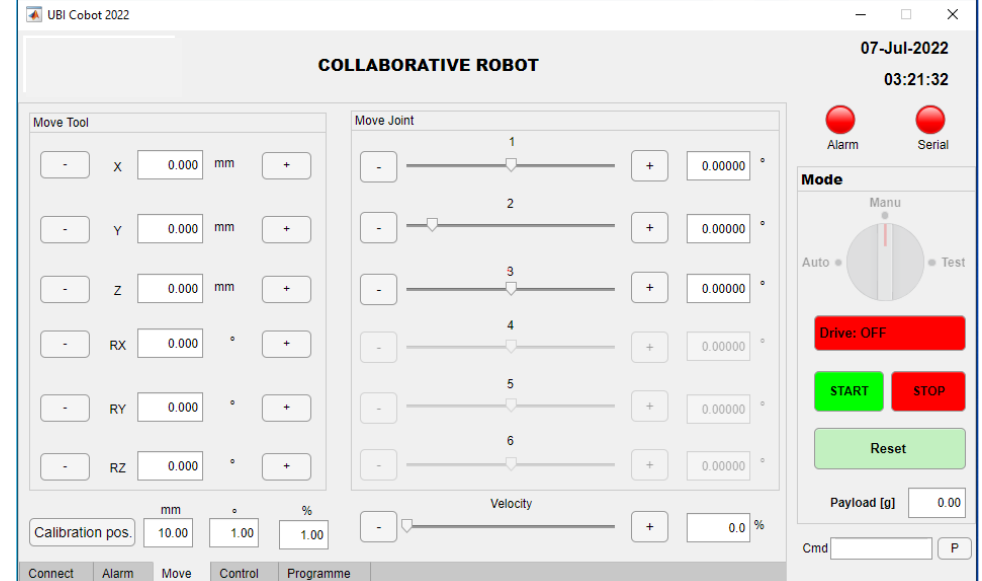
Figure 13. User interface; move menu.